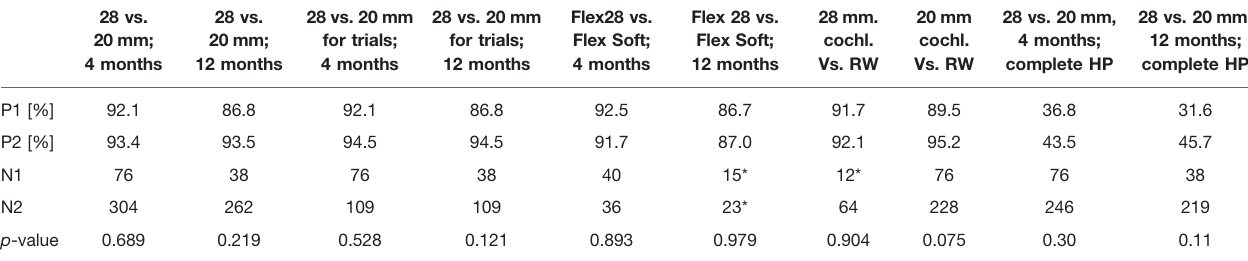
TABLE 4 | The pairwise HP comparison statistical tests outcomes. * Comparisons are insuf fi cient due to small sample size. 28 vs. 20 mm;